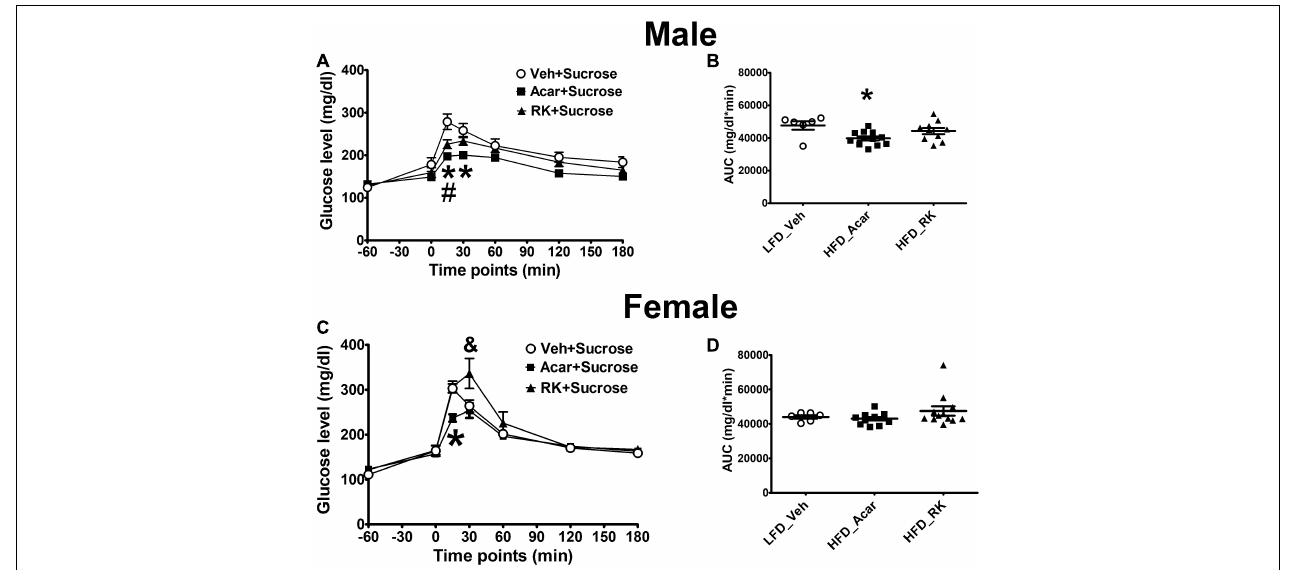
FIGURE 1 | Acute effect of raspberry ketone (RK, 200 mg/kg) on glucose response to oral load of sucrose (4 g/kg) in male and female mice. Mice were fed with high-fat diet (HFD, 45% fat) or low-fat diet (LFD, 10% fat) for 17 weeks. RK, acarbose, and vehicle were administered 1 h prior to carbohydrate meal test. RK prevented peak glucose elevation (A) but not area under curve (AUC) of glucose (B) in male mice. RK increased blood glucose at 30 min (C) but not glucose AUC in female mice (D) . Data are represented as mean ± standard error of the mean (SEM). * p < 0.05 acarbose vs. vehicle, # p < 0.05 RK vs. vehicle, and & p < 0.05 RK vs. vehicle and acarbose. Repeated measures with analysis of variance (ANOVA) for glucose response analysis; one way ANOVA for AUC analysis, followed by Newman Keuls post hoc testing. LFD_Vehicle ( n = 6/sex); HFD_Acarbose ( n = 12/sex); HFD_RK (males: n = 10; females: n = 12).